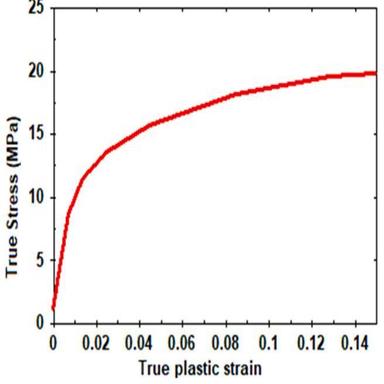
True stress–strain curve used to define the material properties of lattice structures.